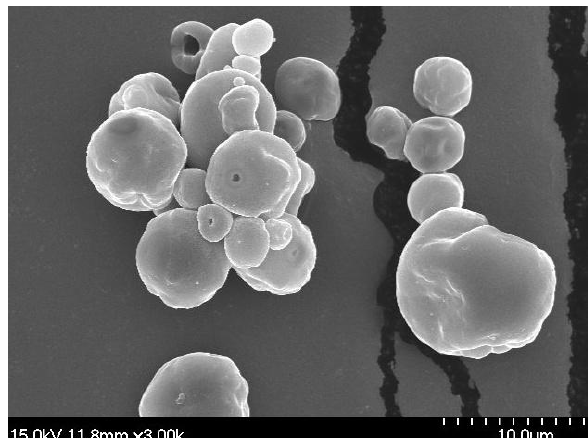
Figure 1. Scanning electron microphotographs (SEM) of powdered microcapsules of peanut sprout